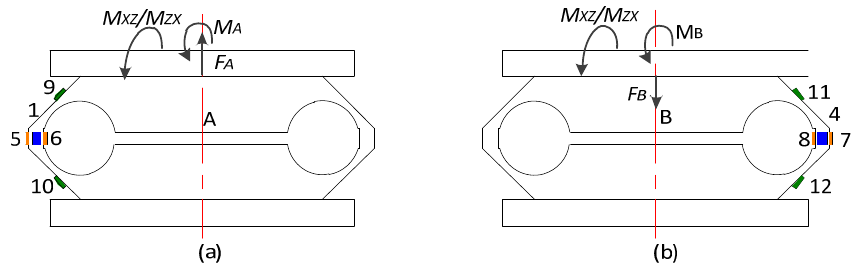
Figure A6. ( a ) Elastic Beam A under Y axial moment; ( b ) Elastic Beam B under Y axial moment. Based on Equation (A9), the output signals of U X and U Z are given below: